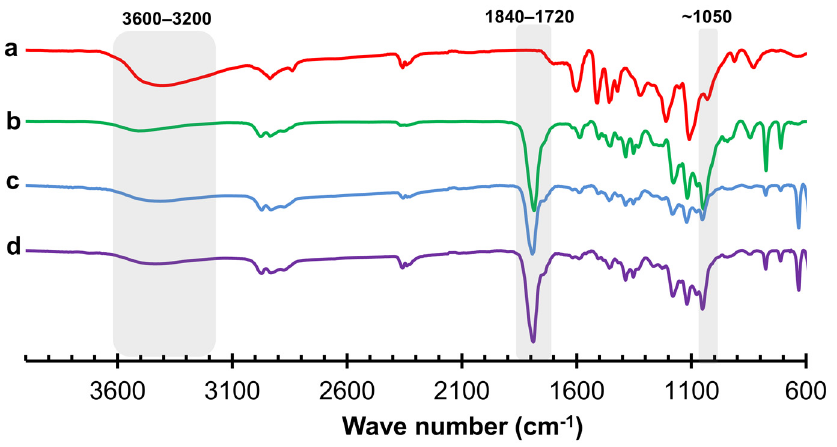
Figure 12. FTIR normalized spectra of ( a ) kraft lignin, ( b ) Non-optimized polyol, ( c ) Crude lignin- based polyol for rigid PU foam and ( d ) Crude lignin-based polyol for PU adhesives.